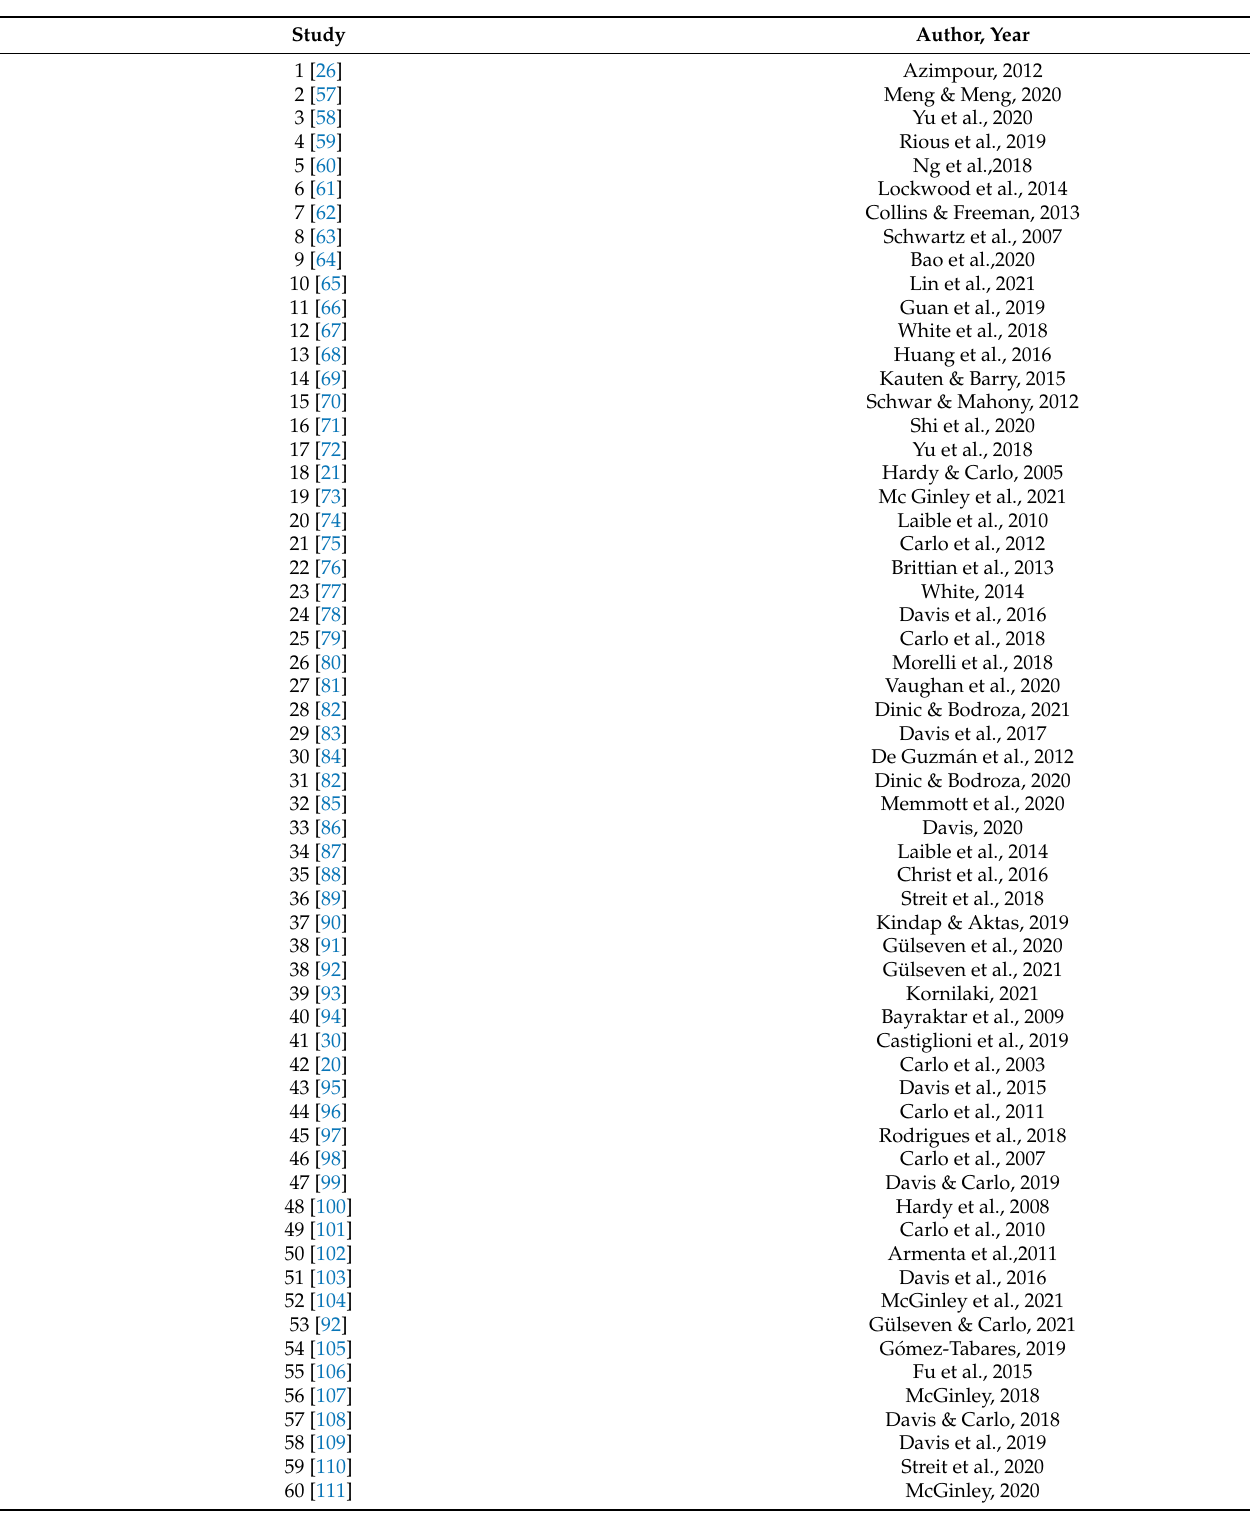
Table A2. Numbering of the studies included in the